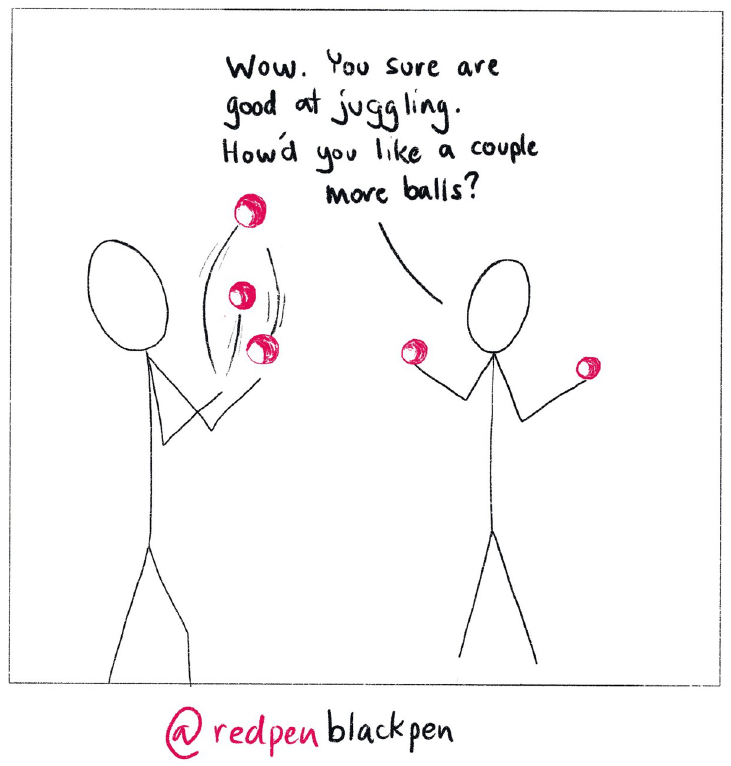
Fig 4. Juggling, always juggling. As a lab head, your duties may stretch your abilities to accomplish things. Be aware that if you are viewed as successful, you will be asked to take on even